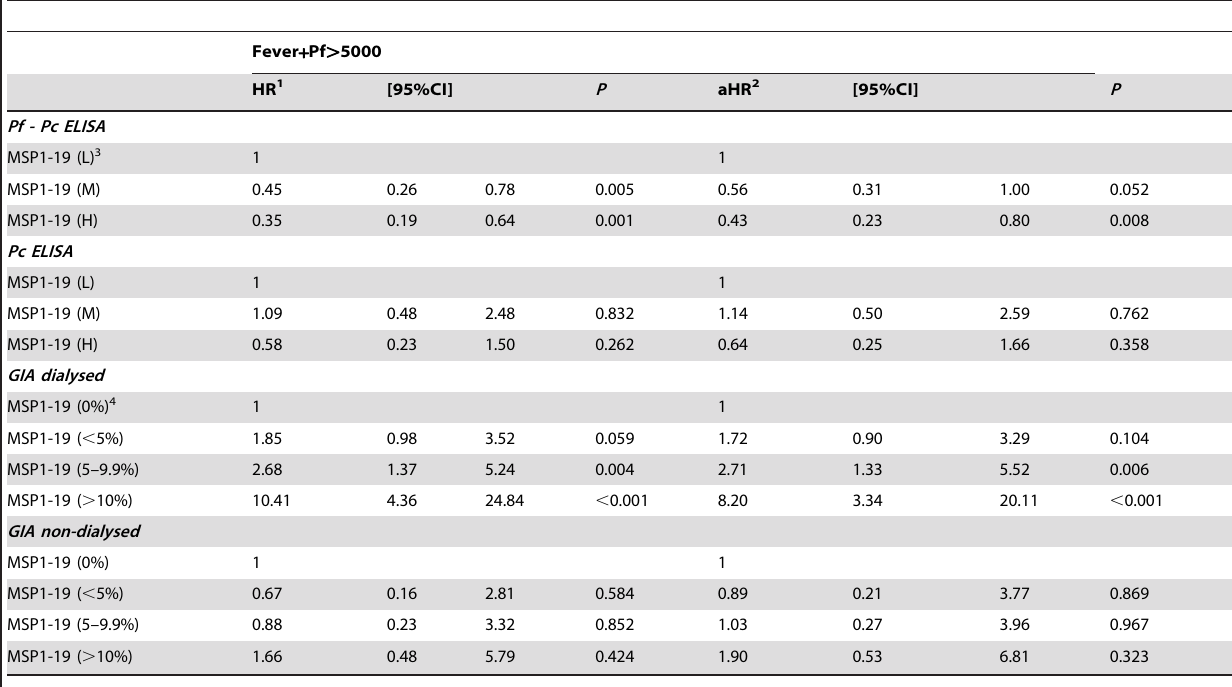
Table 2. Cox regression analysis of the association of MSP1-19 responses with symptomatic and high density parasitemia.